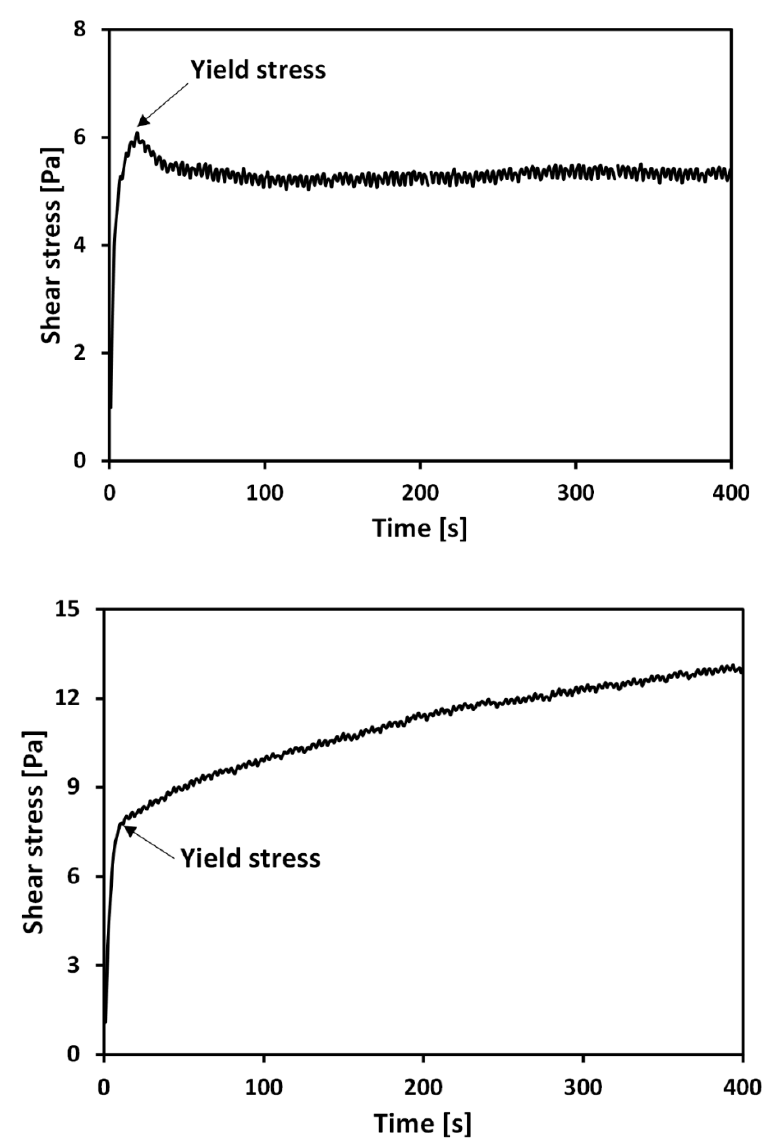
Figure 3. Typical stress–time curves of ( a ) untreated (water content = 218%) and ( b ) treated (water content = 263%) clays.